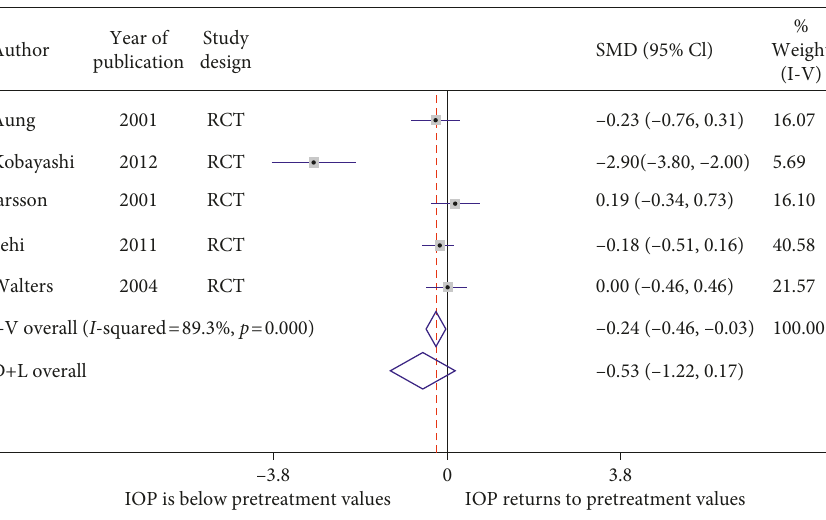
Figure 5: Forest plot of 5 studies of latanoprost